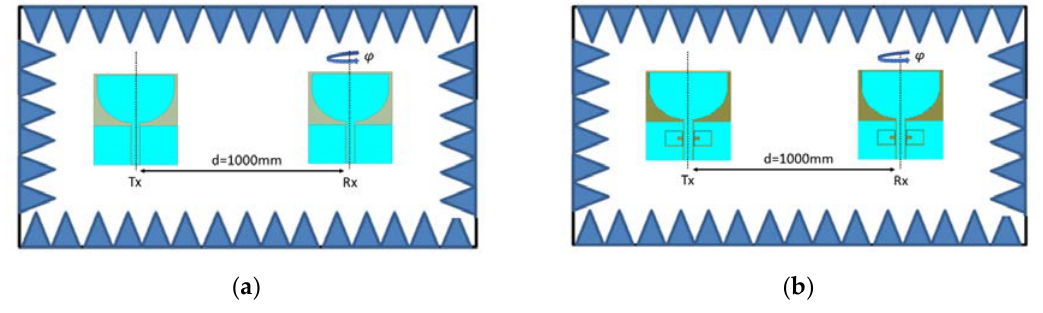
Figure 4. Measurement setup in an anechoic chamber; ( a ) Reference wide-band antenna; ( b ) Switchable filter wide-band antenna.